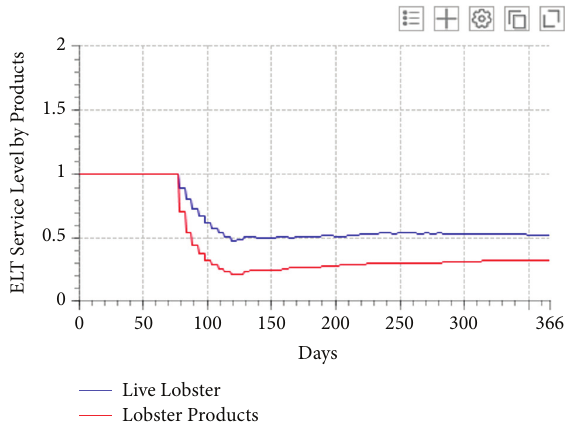
Figure 5: ELT service level by products (per product).